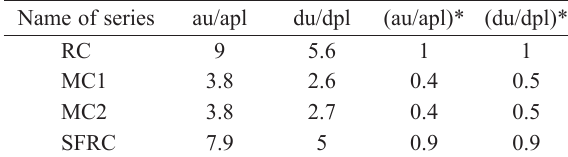
Table 3. Ductility values of beams tested